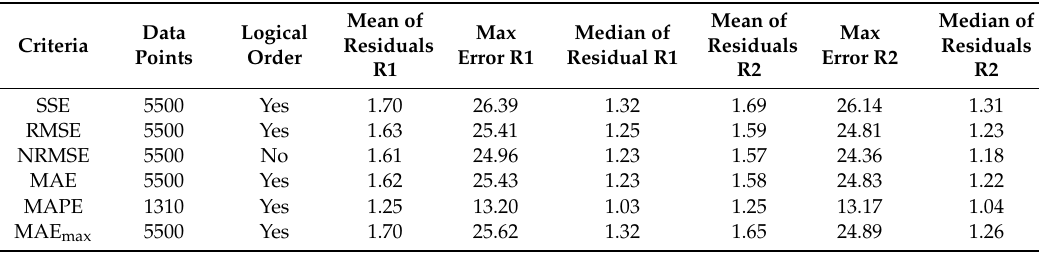
Table 1. Comparison of criteria in a consumer cost case study.